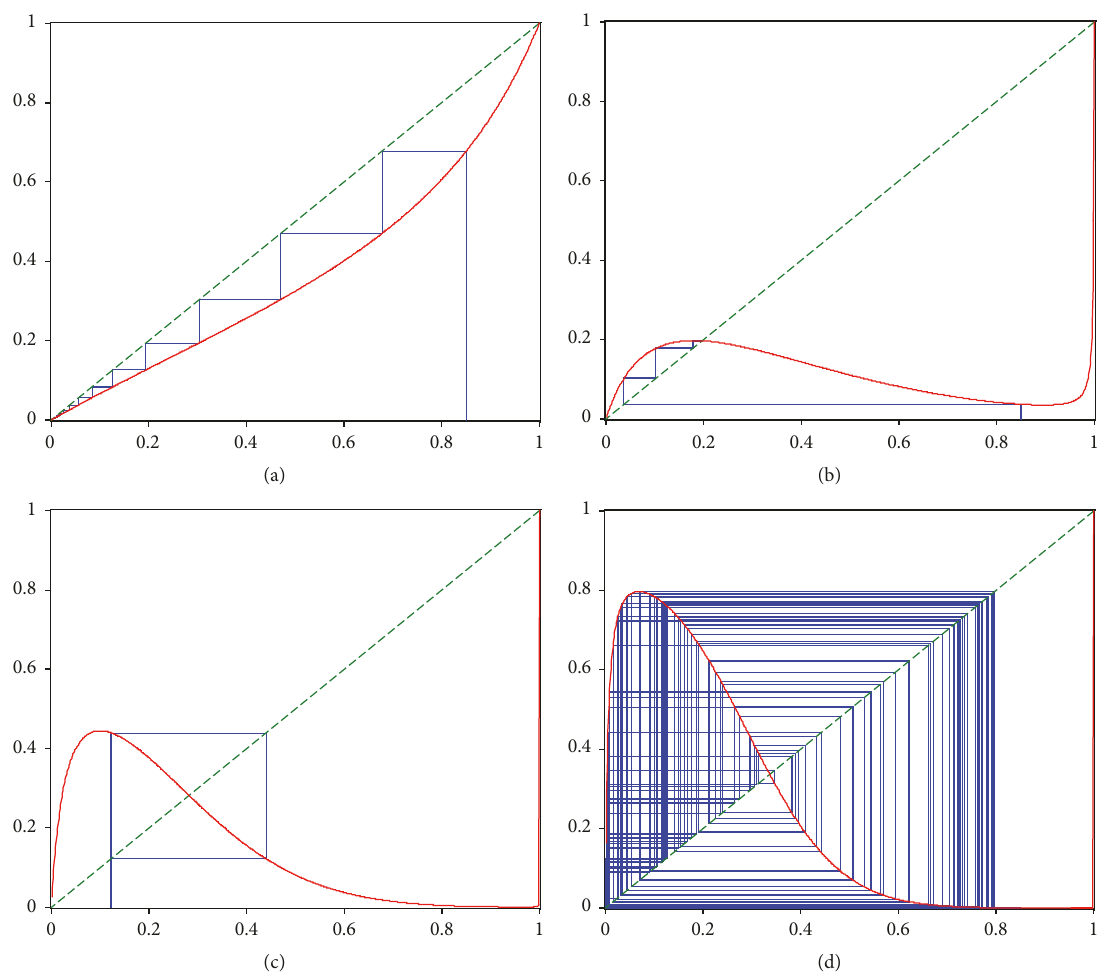
Figure 2: The graph of 𝑓 for 𝑤 𝑥 = 1 , 𝑤 𝑦 = 1.5 , and Δ = 0.1 , 𝑎(0) = 0.85 in (a), Δ = 0.3 , 𝑎(0) = 0.85 in (b), Δ = 0.37 , 𝑎(0) = 0.122 in (c) and Δ = 0.42 , 𝑎(0) = 0.85 in (d), respectively.